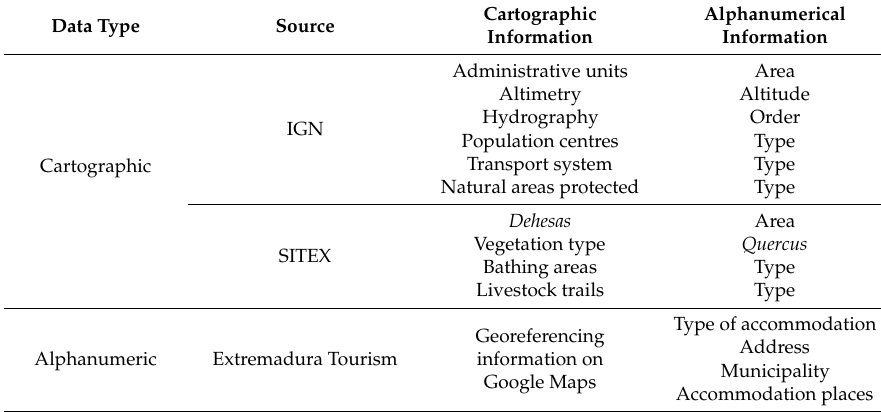
Table 2. GIS design project.